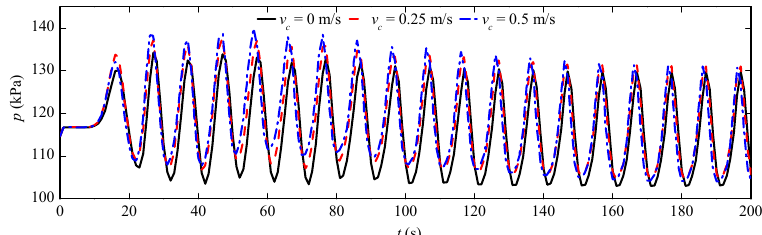
Figure 3. Variation of wave pressure, 𝑝 at the seabed bottom for different current velocities. Figure 4. Variation of wave pressure, p at the seabed bottom for different current